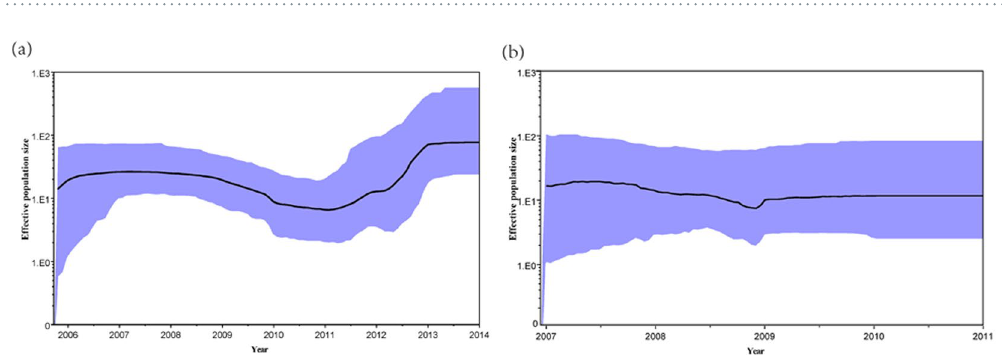
Figure 5. ( a ) Bayesian skyline plot with 92 Chinese BA9 sequences from 2006 to 2014. ( b ) Bayesian skyline plot with 43 Chinese BA10 sequences from 2008 to 2011. The thick solid line is the estimated median, and the grey areas show the upper and lower bounds of the 95% HPD